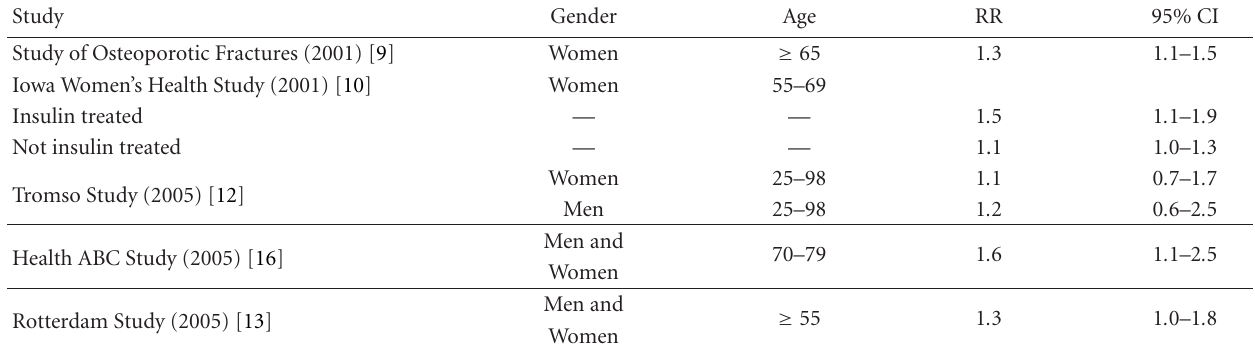
Table 2: Adjusted relative risk of nonvertebral fracture with type 2